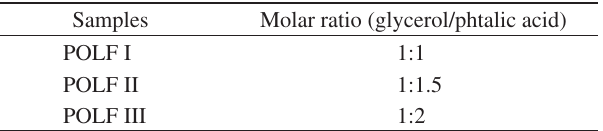
Table 1. Molar ratio from POLF series. Samples